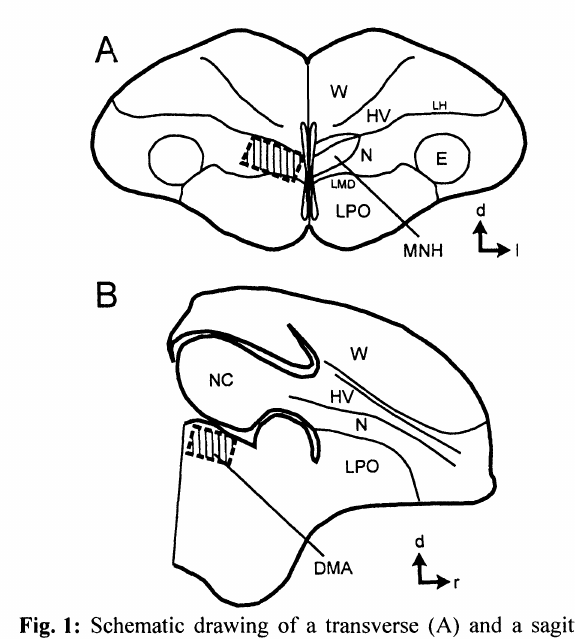
d DMA Schematic drawing of a transverse (A) and a sagittal section (B) of a domestic chick brain. Hatched regions indicate the slices used for cocultures. Abbreviations: d: dorsal; DMA: nucleus dorsomedialis anterior thalami; E: ectostriatum; HV: hyperstriatum ventrale; 1: lateral; LH: lamina hyperstriatica; LMD: lamina medullaris dorsalis: LPO: lobus parolfactorius; MNH: mediorostral neo- striatum and hyperstriatum ventrale; N: neostriatum; NC: neostriatum caudale; r: rostral; W: